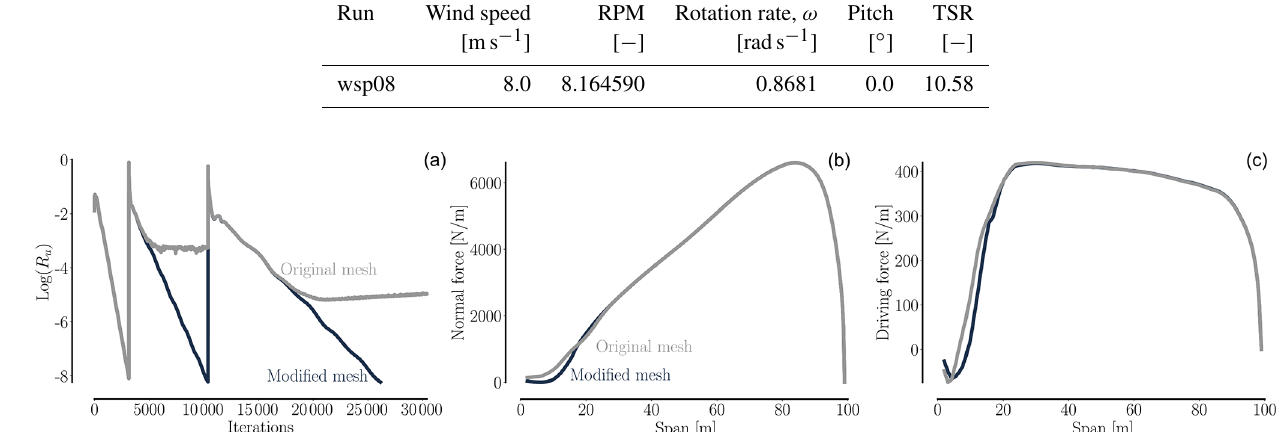
Figure 5. A comparison of the baseline mesh before (gray) and after (black) root modifications reveal that the modified baseline mesh ensures a deep convergence (a) on all the grid levels: L3 (it = 0–4000), L2 (it = 4000–12000), and L1 (it = 12000–30000). Mesh levels are listed in Table 3. Also the normal force (b) and driving force (c) are visualized. As seen, the spanwise forces only differ noticeably within the 30m farthest